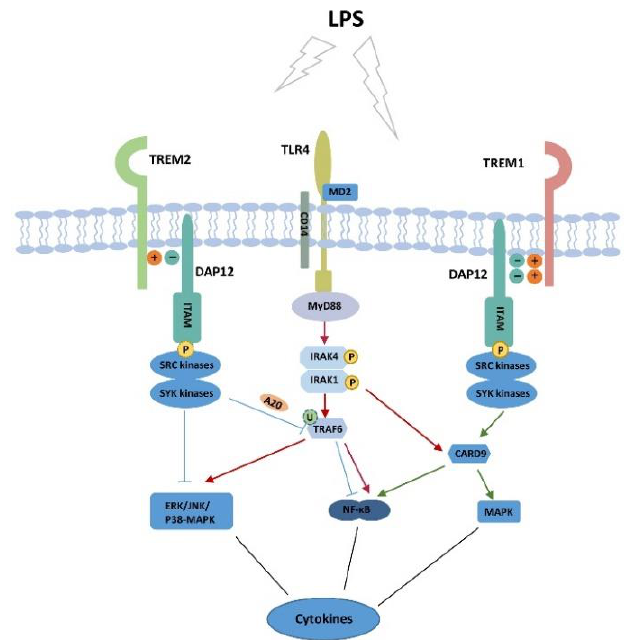
Figure 1. The inflammatory regulation mechanism in a TREM1 / 2-TLR4-dependent manner in the liver. Upon the stimulation LPS, TLR4 is activated and produces cytokines via NF- κ B and MAPK signaling pathways. TREM1 phosphorylates ITAM by activating Src and Syk kinases and regulates CARD9. The upstream signal passed to CARD9 augments inflammation via NF- κ B and MAPK. The IRAK1 and TRAF6 in TLR4 signaling pathway also promote inflammation via CARD9 and NF- κ B, respectively. TREM2 mainly alleviates the inflammation by binding to DAP12 with low a ffi nity. Partial activation of DAP12 reduces the phosphorylation Src and Syk kinases, inhibiting the inflammatory factor mediated by ERK / p38-MAPK / JNK pathway. TREM2 also makes A20 negatively regulate ubiquitination of TRAF6 and decreases inflammation mediated by NF- κ B. LPS, lipopolysaccharide; TREM2, triggering receptors expressed on myeloid cells 2; DAP12, DNAX-activation protein of 12 kDa; TLR4, toll-like